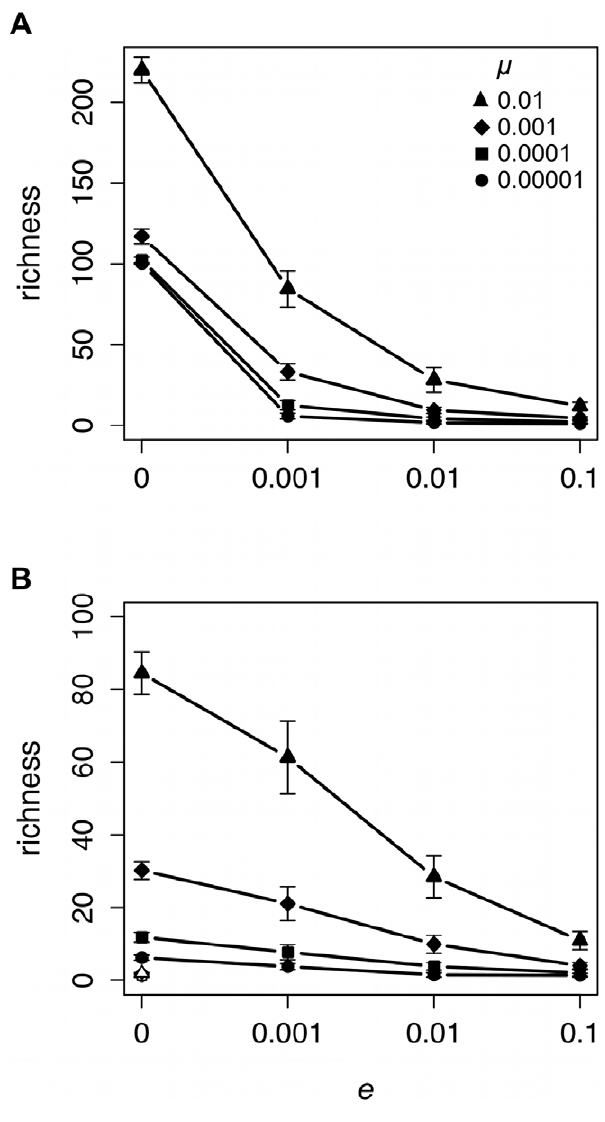
Figure 2. Local extinction rate ( e ) affects richness under equilibrium (A) and non-equilibrium (B) conditions. Each data point provides the mean 6 1 standard deviation of 20 unique simulated populations. Black symbols represent data collected from populations with unbiased cultural transmission and white symbols data collected from populations with conformist cultural